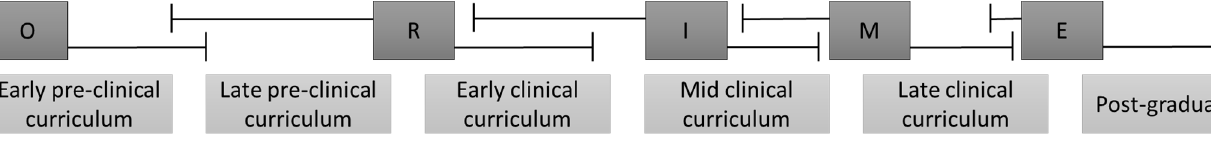
Figure 2. A typical expectations or progression of veterinary learners through the (O)RIME frame- work. A significant overlap of the times when a particular learner progresses from one level of the framework to the next is common. O—Observer. R—Reporter. I—Interpreter. M—Manager. E— Educator. Prepared using information from [24,27–29] .